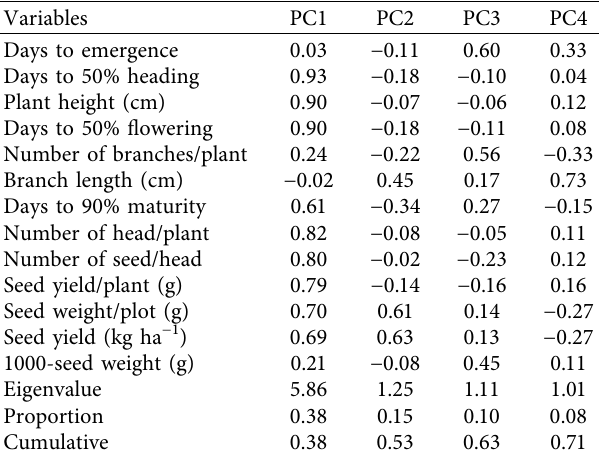
Table 4: Principal component analysis for 13 quantitative traits of 80 Vernonia galamensis